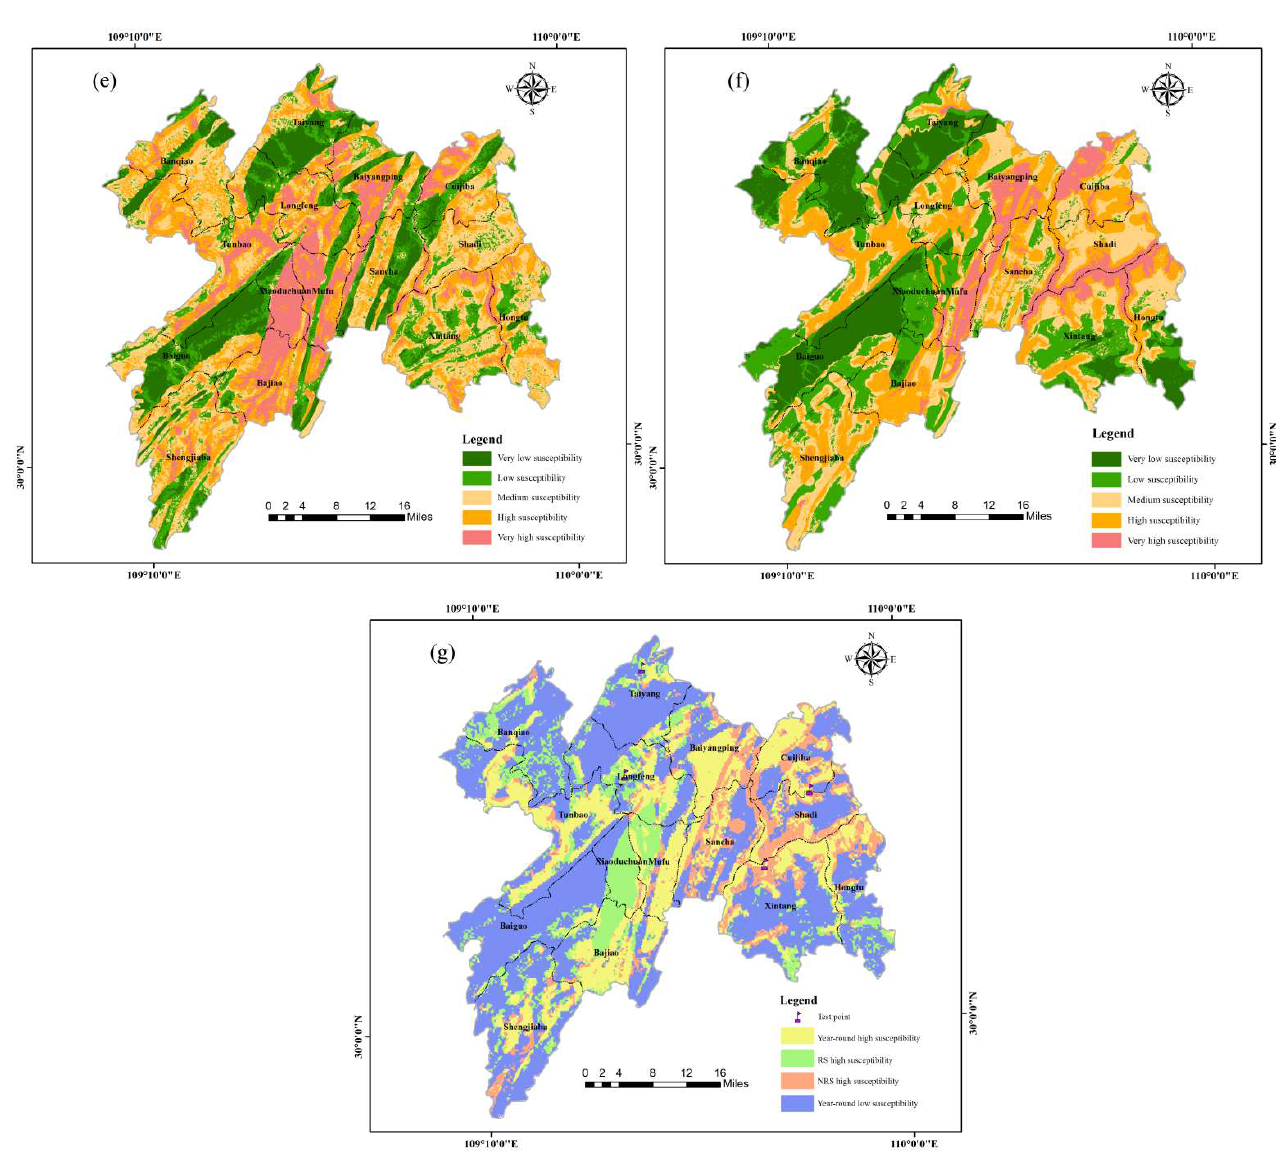
Figure 4. Landslide susceptibility zoning map: ( a ) AHP model in RS; ( b ) AHP model in NRS; ( c ) IV model in RS; ( d ) IV model in NRS; ( e ) AHP-IV model in RS; ( f ) AHP-IV model in NRS; ( g ) Integrate landslide susceptibility zoning map.